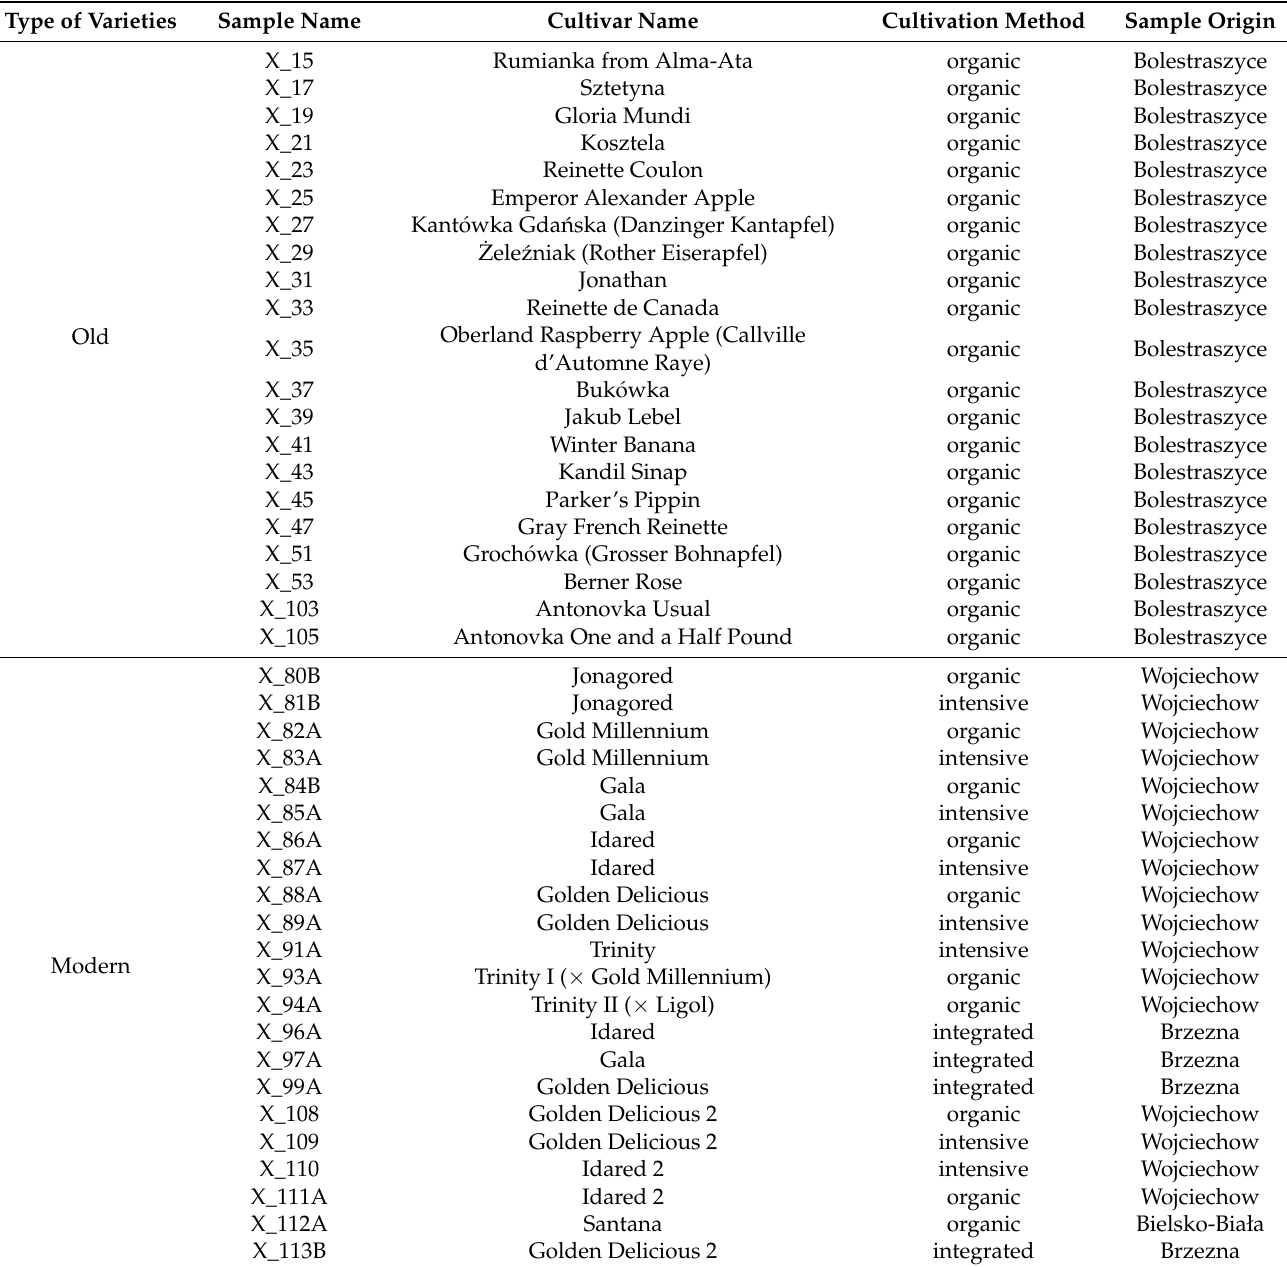
Table 5. Characteristics of apple fruit samples used in the